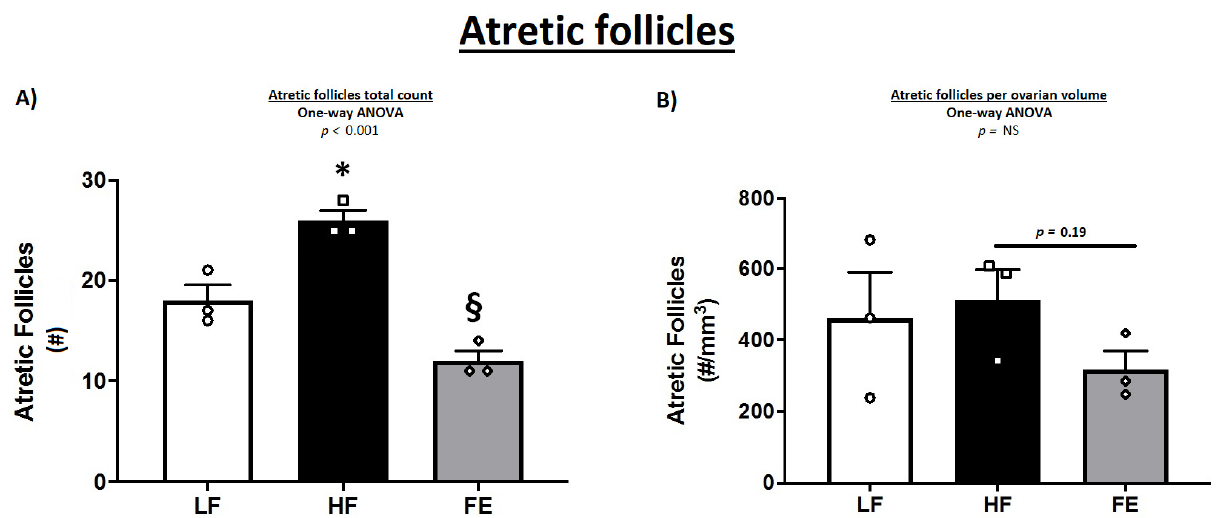
Figure 10. Effects of the ‘Fertility Enhancer’ supplement on follicular atresia in Western diet-fed C57BL/6J mice. ( A ) Total atretic follicles per section. ( B ) Total atretic follicles per ovarian volume. LF = Low Fat Diet, HF = Western Diet (WD), and FE = ‘Fertility Enhancer’ multi-nutrient supplement with WD. * Significantly different from LF ( p ≤ 0.05). § Significantly different from HF ( p ≤ 0.05).